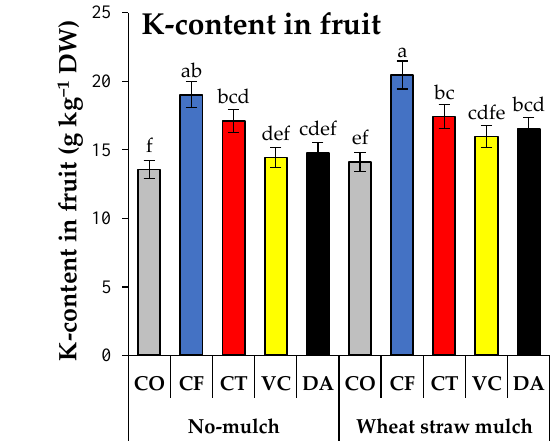
Figure 4. Effect of organic amendments and mulching system on squash fruits. CO = Control (without fertilization), CF = Recommended mineral fertilization (112 kg N ha −1 + 50 kg P 2 O 5 + 75 kg K 2 O ha −1 ), CT = Compost (7.5 t ha −1 ), VC = Vermicompost (7.5 t ha −1 ), DA = Dry Azolla pinnata (3.75 t ha − 1 ). Different letters indicate significant differences according to Duncan’s multiple range test at p ≤ 0.05. Data are means of three replicates ± SE.